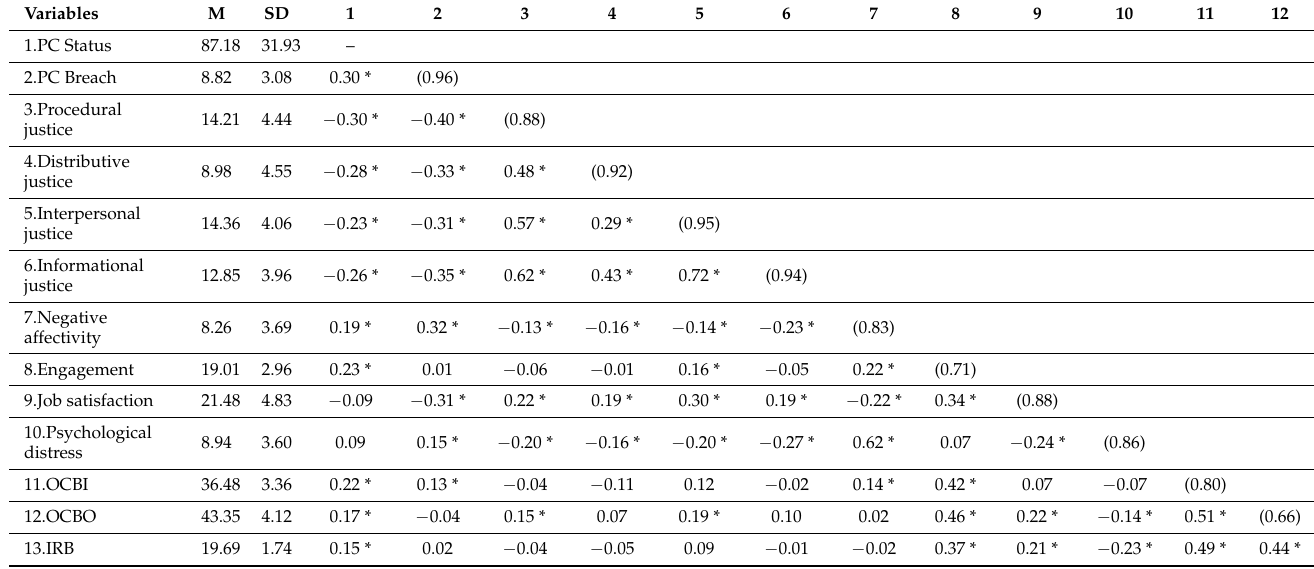
Table 1. Means, standard deviations, correlations and Cronbach’s alpha coefficients of the predictor and outcome